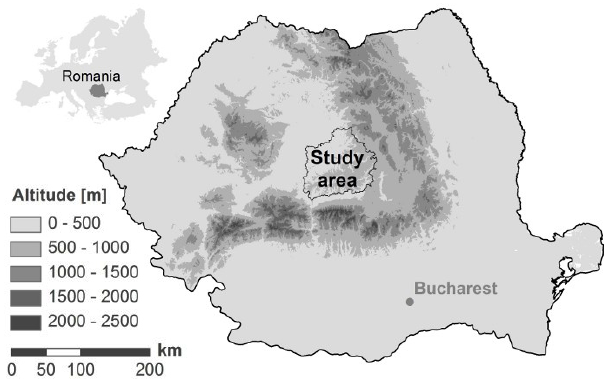
Fig. 2. Map of the study area in southern Transylvania, Romania, in the foothills of the Carpathian